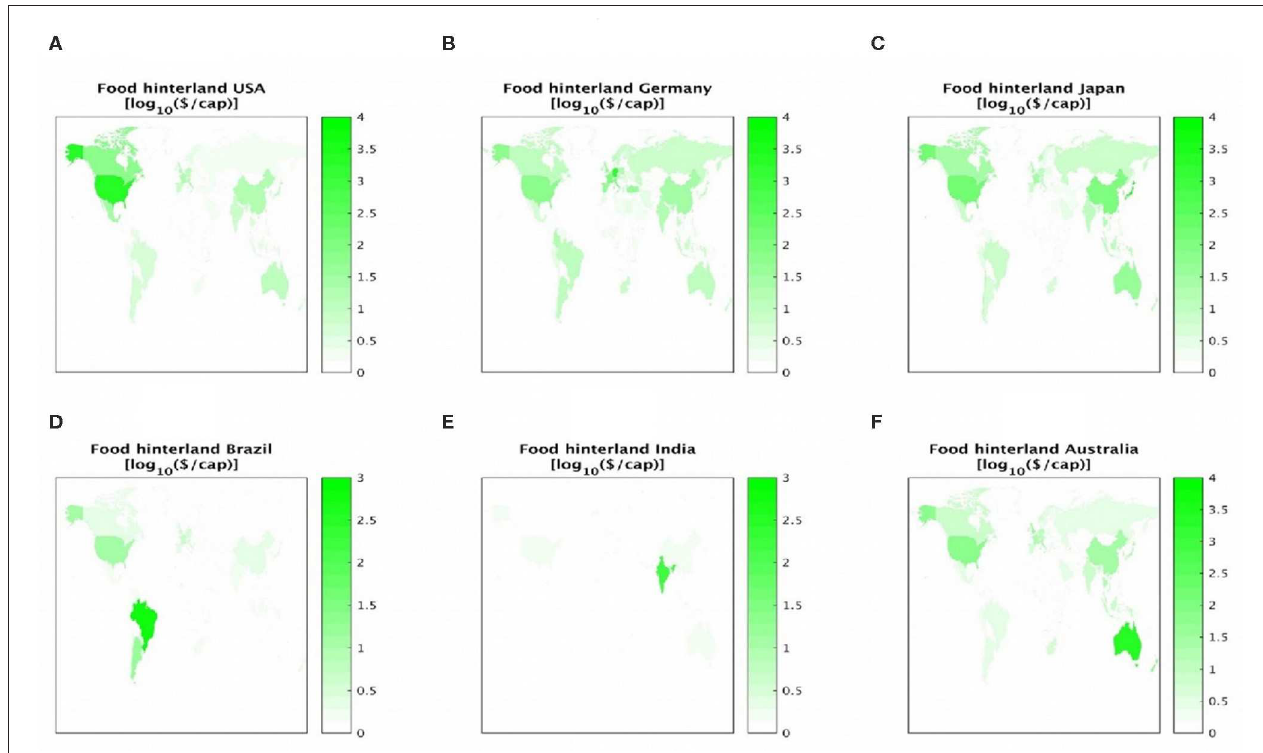
FIGURE 2 | Global food hinterlands of countries with high populations. Global food hinterlands of the USA (A) , Germany (B) , Japan (C) , Brazil (D) , India (E) , and Australia (F) . To relate the production values to population size in the consuming countries, the maps are color-coded in units of log 10 (US$/cap), so that e.g., 3 =